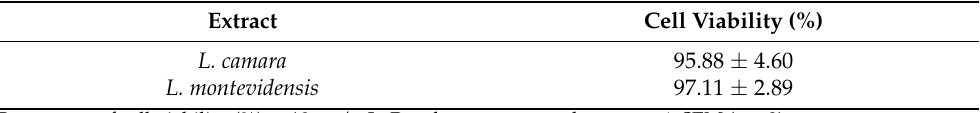
Table 2. The effects of Lantana extracts on the release of lactate dehydrogenase (LDH) in human neutrophils.